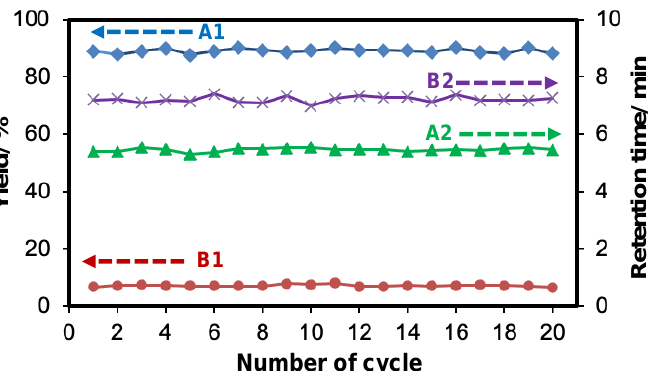
Figure 6. The chemical stability test of Pd(II)-immobilized monolithic microreactor ( M1 ) through the reaction of bromobenzene with 4-methylphenylboronic acid. Reaction time inside M1 was 12 s. Other conditions are simar as in Figure 3. A1 and A2 are the cross-coupling product and retention time of 4-methylbiphenyl, respectively. B1 and B2 are the byproduct and retention time of 4,4 (cid:48)